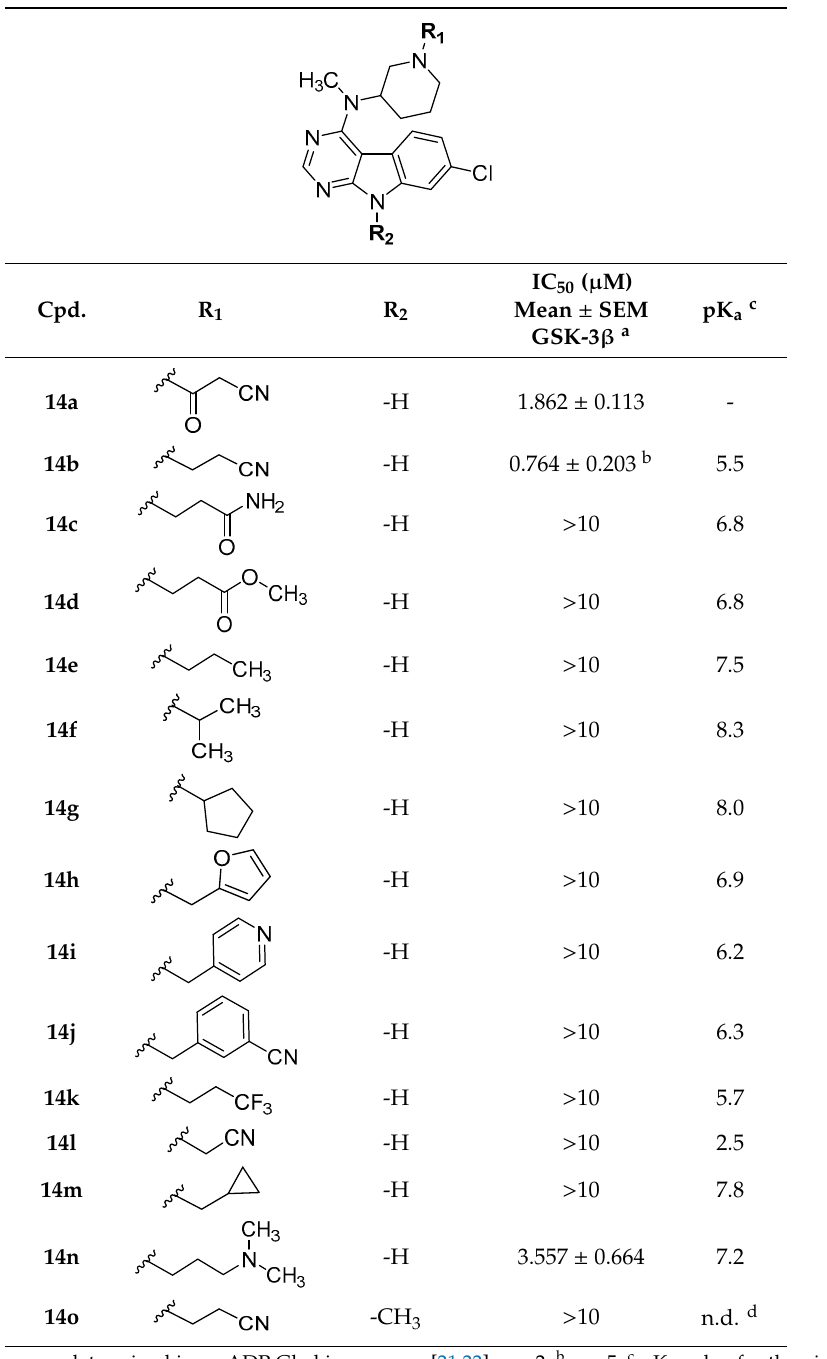
Table 1. Structures, biological activity and calculated pK a values of piperidine derivatives 14a – o . Molecules 2019 , 24 , x FOR PEER